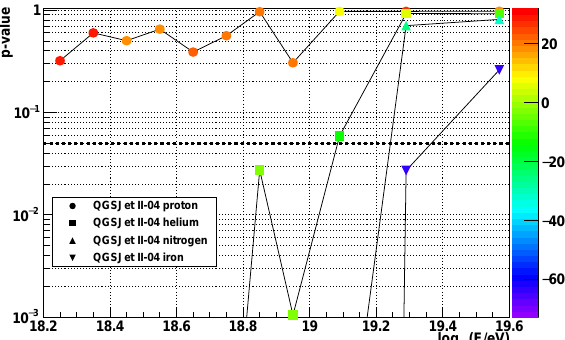
Figure 5: BR / LR hybrid X max compatibility with di ff erent simulated elements